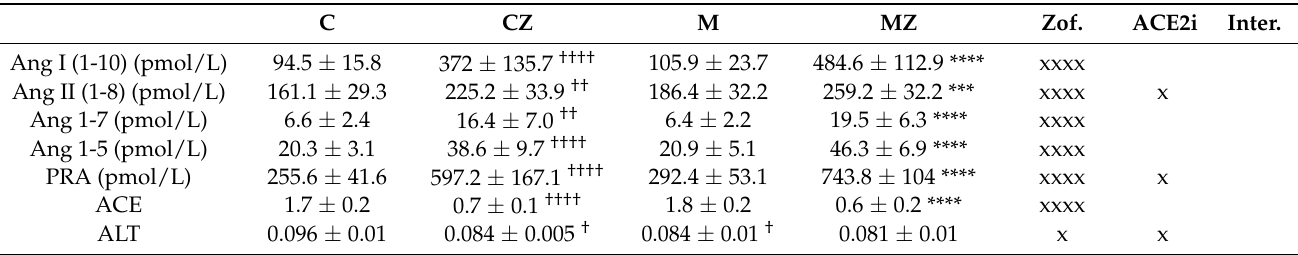
Table 2. Angiotensin concentrations in blood plasma.